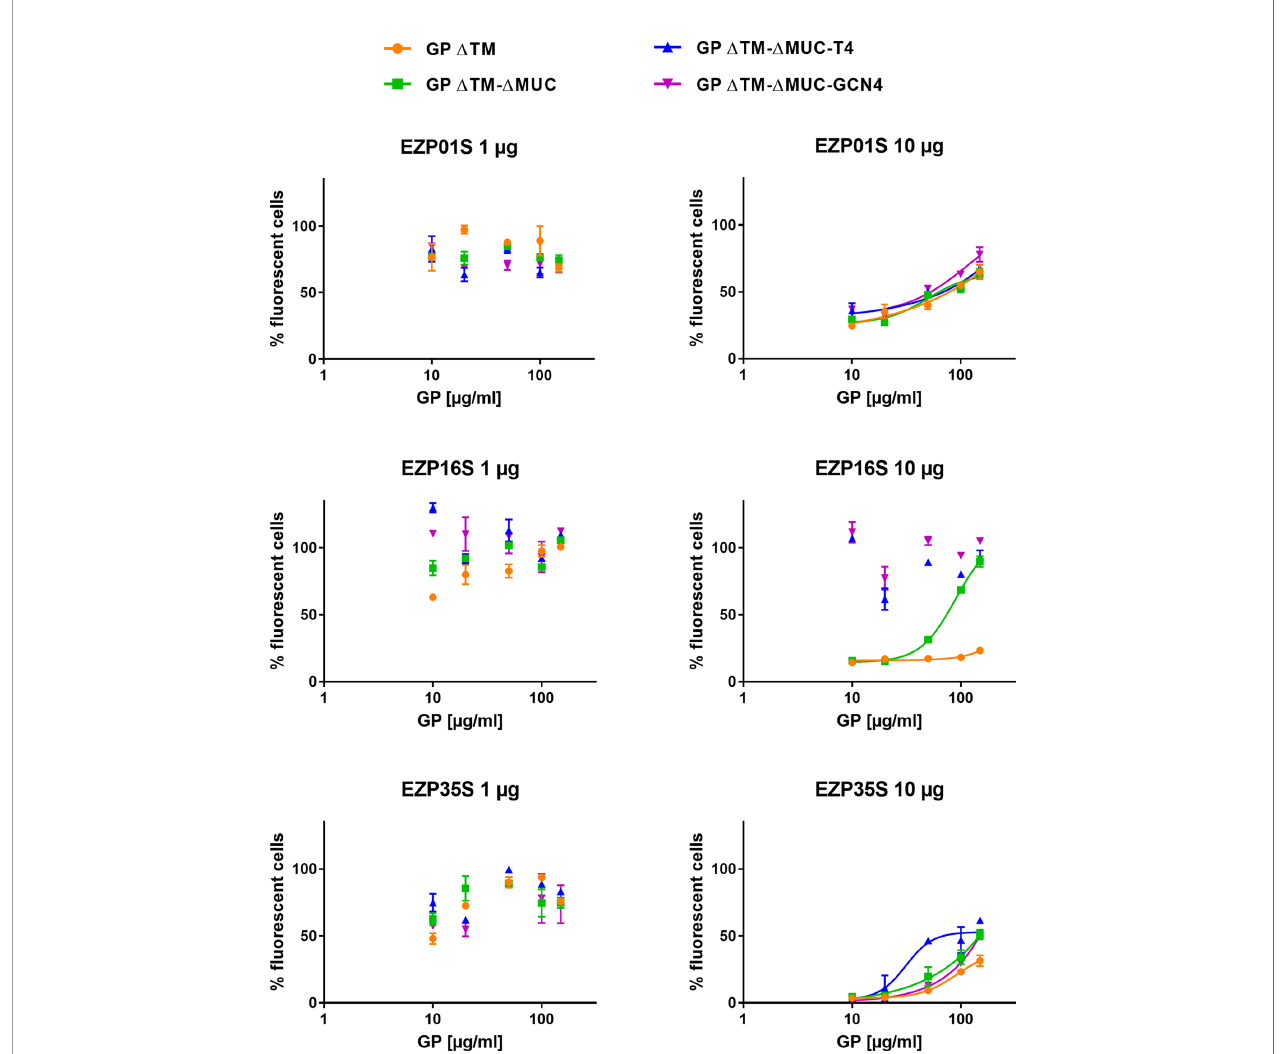
FIGURE 5 | Recombinant GPs are recognized by neutralizing mAbs in solution. An evaluation of the inhibitory activity of GP D TM, GP D TM- D MUC, GP D TM- D MUC- T4, and GP D TM- D MUC-GCN4 was performed on a pseudo-type infection assay in presence of EZP01S, EZP16S, or EZP35S as neutralizing antibodies. When possible, dilution points were fi tted with a four-parameter dose-response